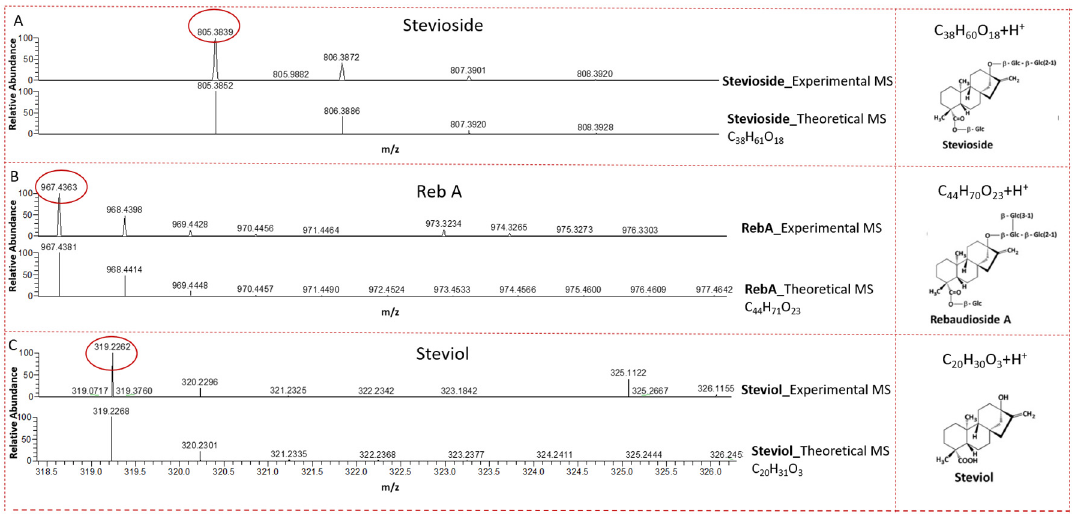
Figure 2. Experimental and theoretical mass spectrum of CSHS using ion trap MS in positive ion mode. ( A ) Stevioside; ( B ) Reb A; ( C ) steviol. On the right are the structures of the glycosides, along with their molecular formulas.